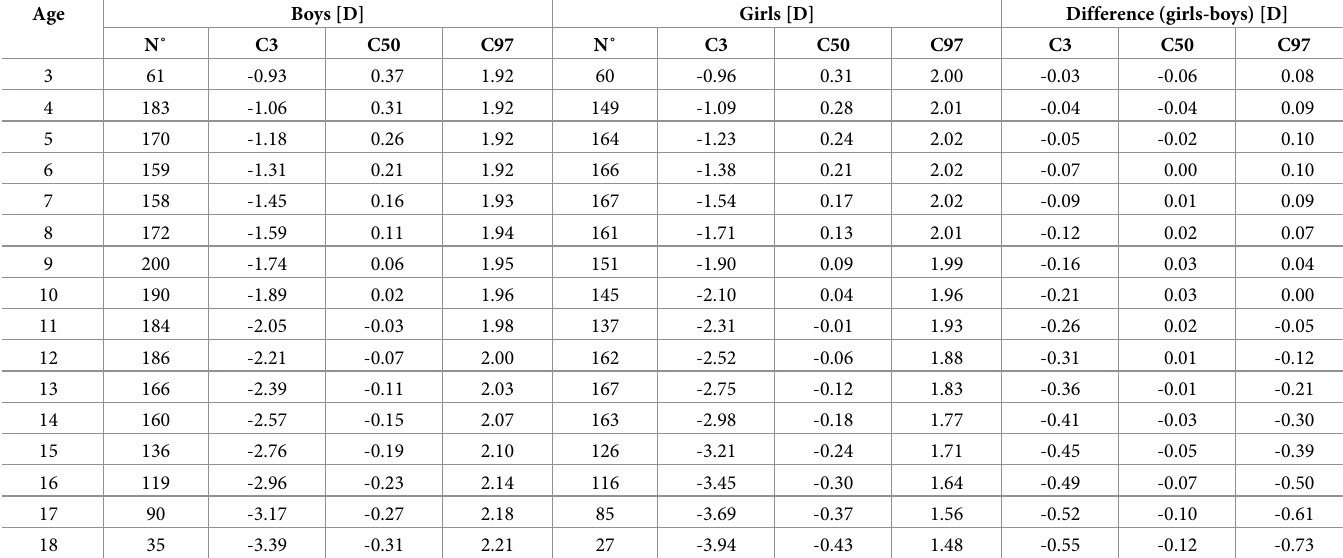
Table 1. 3 rd , 50 th and 97 th centile cut-offs in diopters for boys and girls and comparison between the genders of the LIFE study population. Age